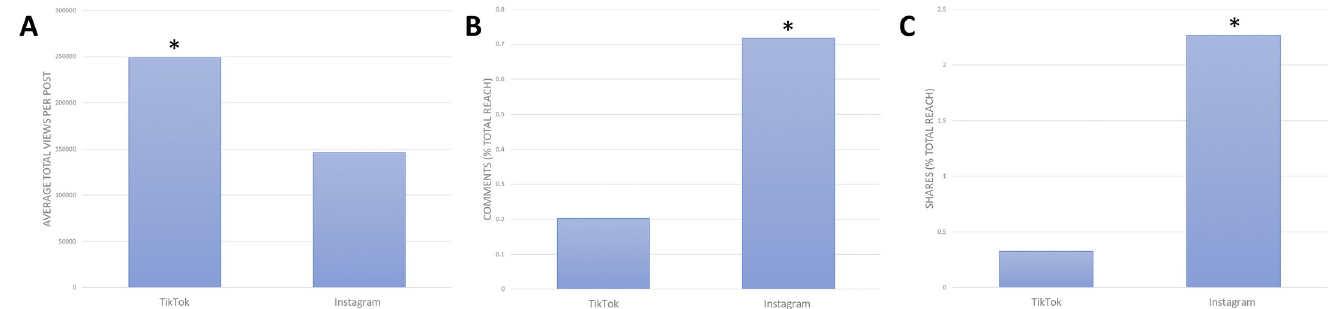
Fig 3. Analytical metric data obtained for similar types of ESC videos posted to the Instagram and TikTok platforms. The similar ESC videos used for comparison purposes between the two platforms were both long experimental-style videos (40–60 seconds in length). � Indicated statistical significance (p < 0.05). A) Average number of video views for ESC posted on TikTok and Instagram. B) Average number of comments as a percentage of total post reach for ESC posted on TikTok and Instagram. C) Average number of shares as a percentage of total post reach for ESC posted on TikTok and Instagram.